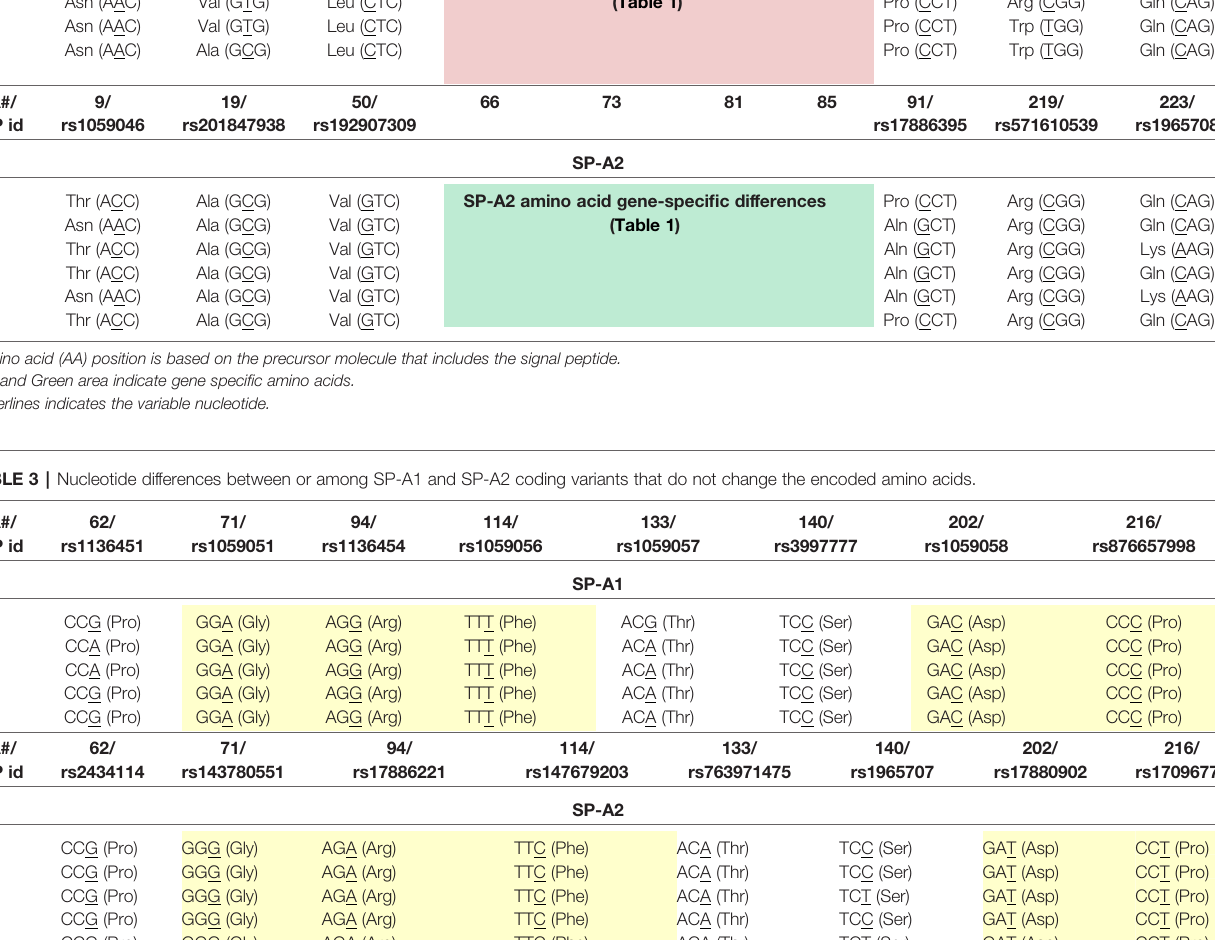
† Amino acid (AA) position is based on the precursor molecule that includes the signal peptide. The nucleotide differences in the columns highlighted in yellow are gene-speci fi c. Underlines indicates the variable nucleotide.